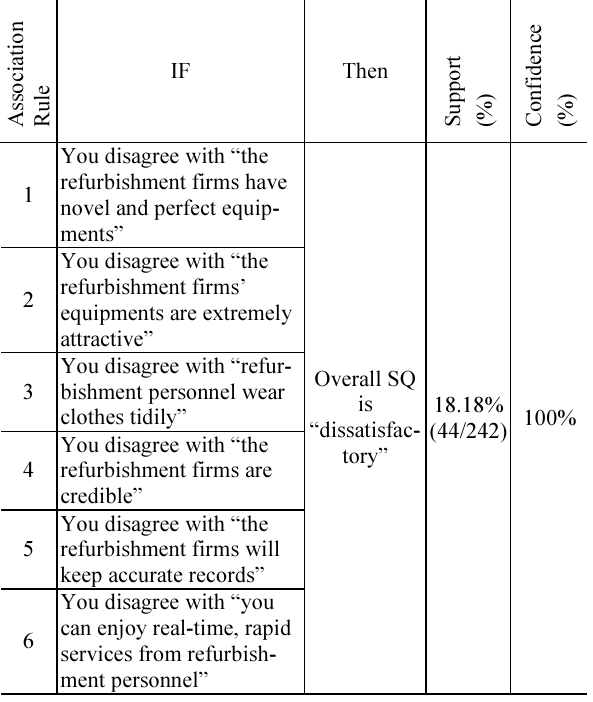
Table 5. Analytical Results of Association Rules for